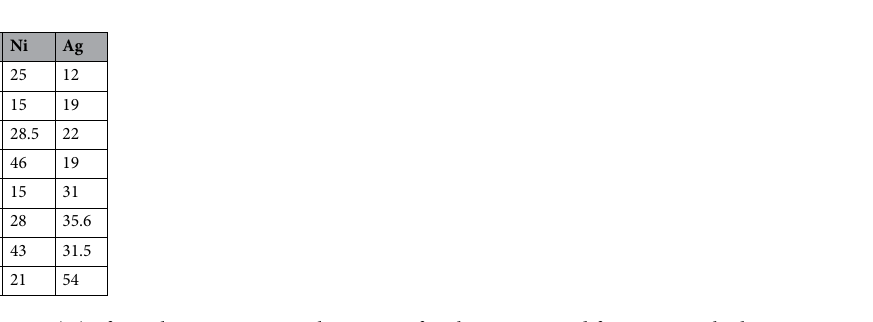
Table 1. Percentage (%) of metal composition at the center of each coupon used for antimicrobial testing